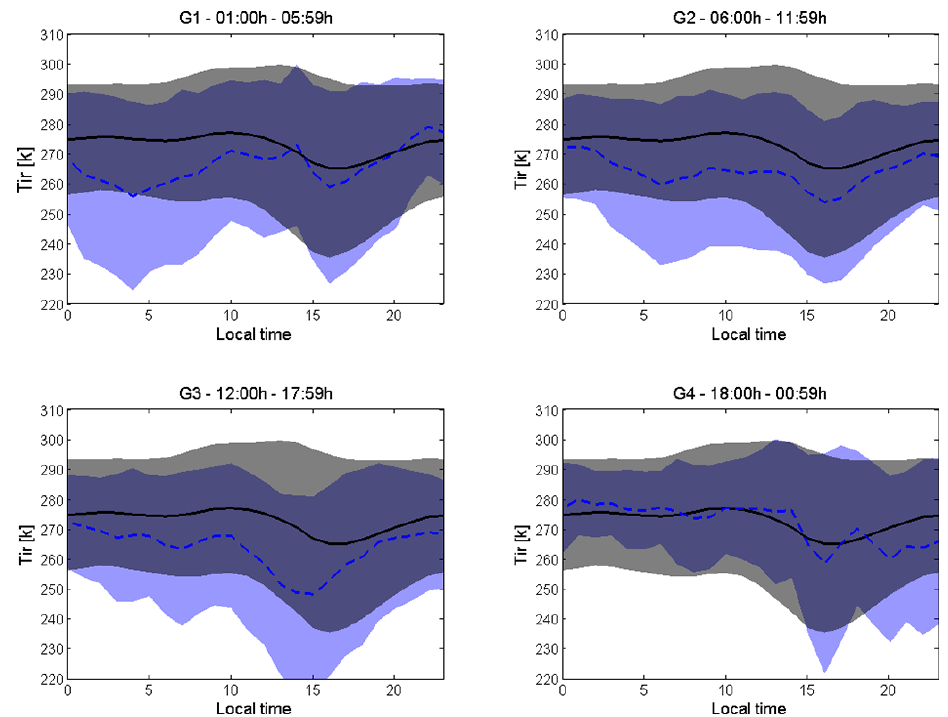
Figure 12. Average diurnal cycle of Tir for the event days in the groups G1 to G4. The dashed blue line represents the average diurnal cycle of Tir relating to the days when the particle growth events for a given group were observed. The black line represents the average diurnal cycle for all days on which PNSD measurements were made. The colored shading represents the standard